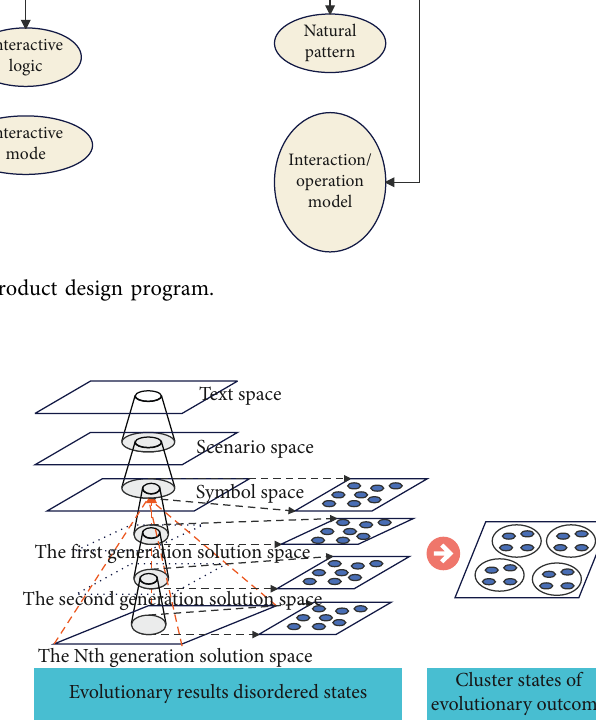
Figure 12: Cognitive fuzzy solution model for interactive evolu- tionary design.